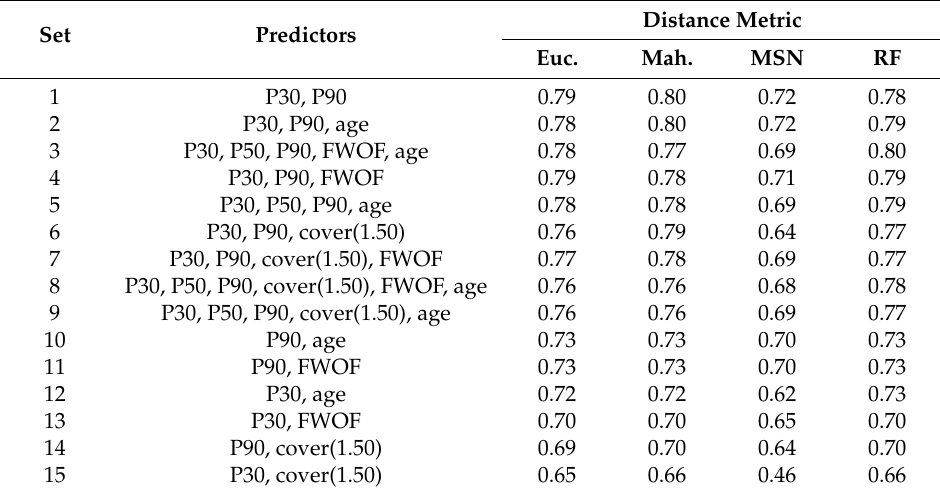
Table 5. Sorted index H values for k-NN (k = 3) dbh predictions for selected predictors sets for all species combined with responses TPH and